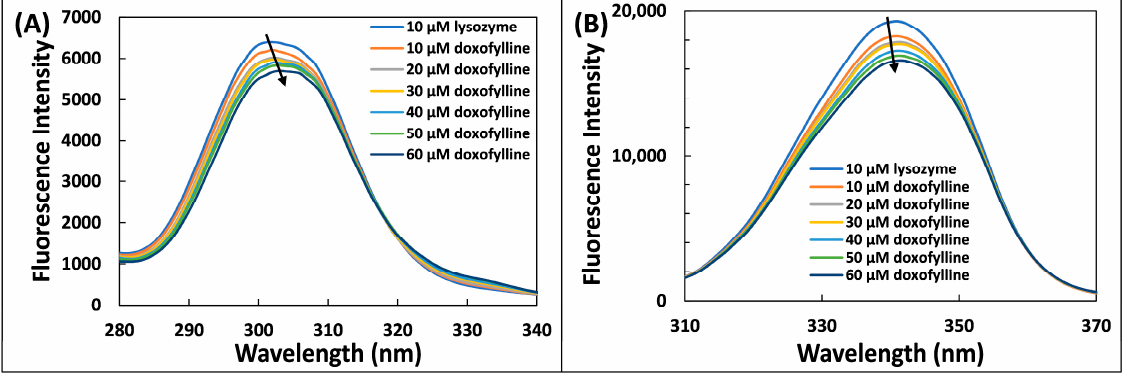
Figure 3. Synchronous fluorescence spectra for the interaction of lysozyme with doxofylline at ( A ) Δλ = 15 nm; ( B ) Δλ = 60.